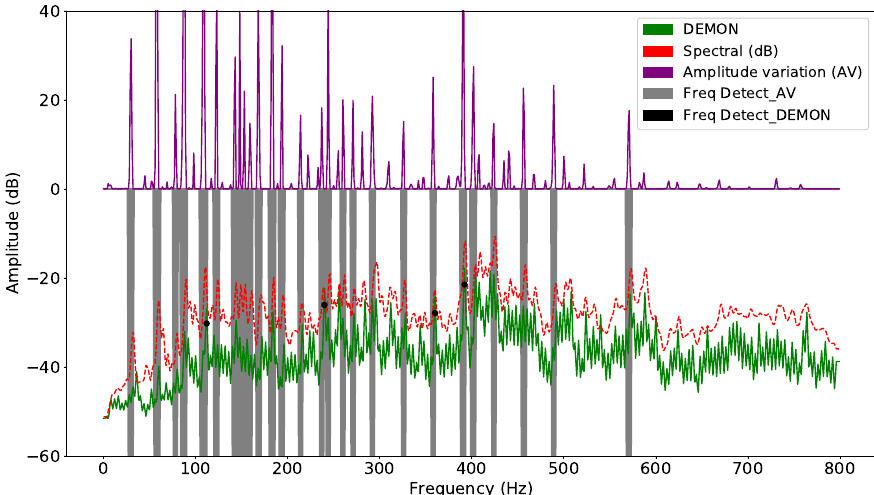
Figure 4. Signal frequency detection by DEMON-AV with Record-1.